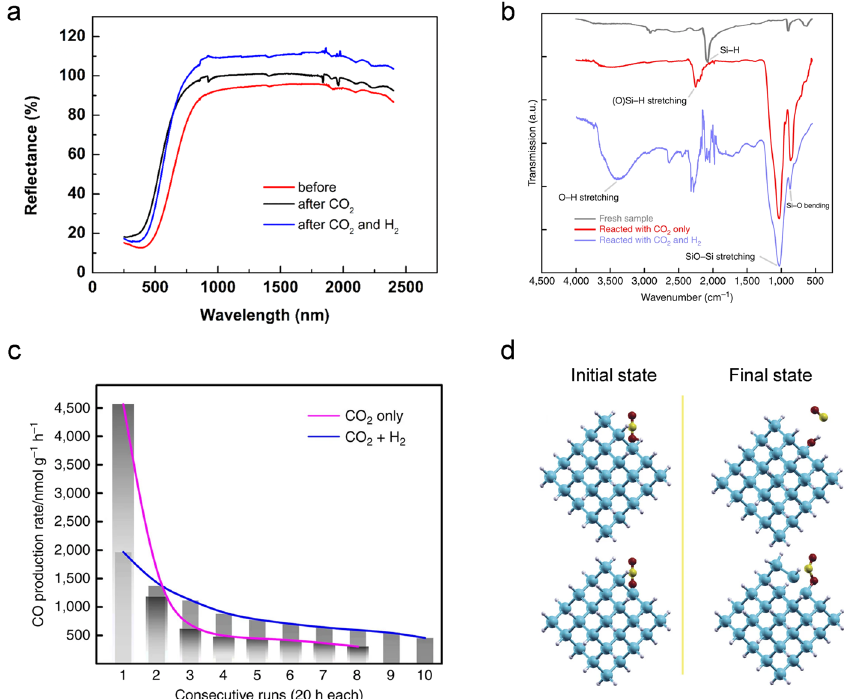
Fig. 3 Catalytic CO 2 reduction by silicon nanocrystal. a UV-vis diffuse re fl ectance spectra of Si nanocrystals deposited on the glass fi ber fi lter. b FTIR spectra of fresh powder of hydride-terminated silicon nanocrystals before and after the reaction. c CO production rates (pure 13 CO 2 in the batch reactor at 150 °C) for eight cycles, and CO production rates ( 13 CO 2 and H 2 with 1:1 ratio in the batch reactor at 150 °C) for 10 cycles, both under light (one sun). d The initial and fi nal optimized models of CO 2 adsorption on SiH (top panel) and Si surface sites (bottom panel) ( a – d are reproduced with permission from ref. 119 , Copyright © Springer Nature